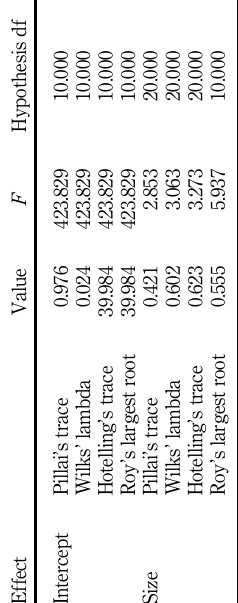
Table 2. Multivariate tests